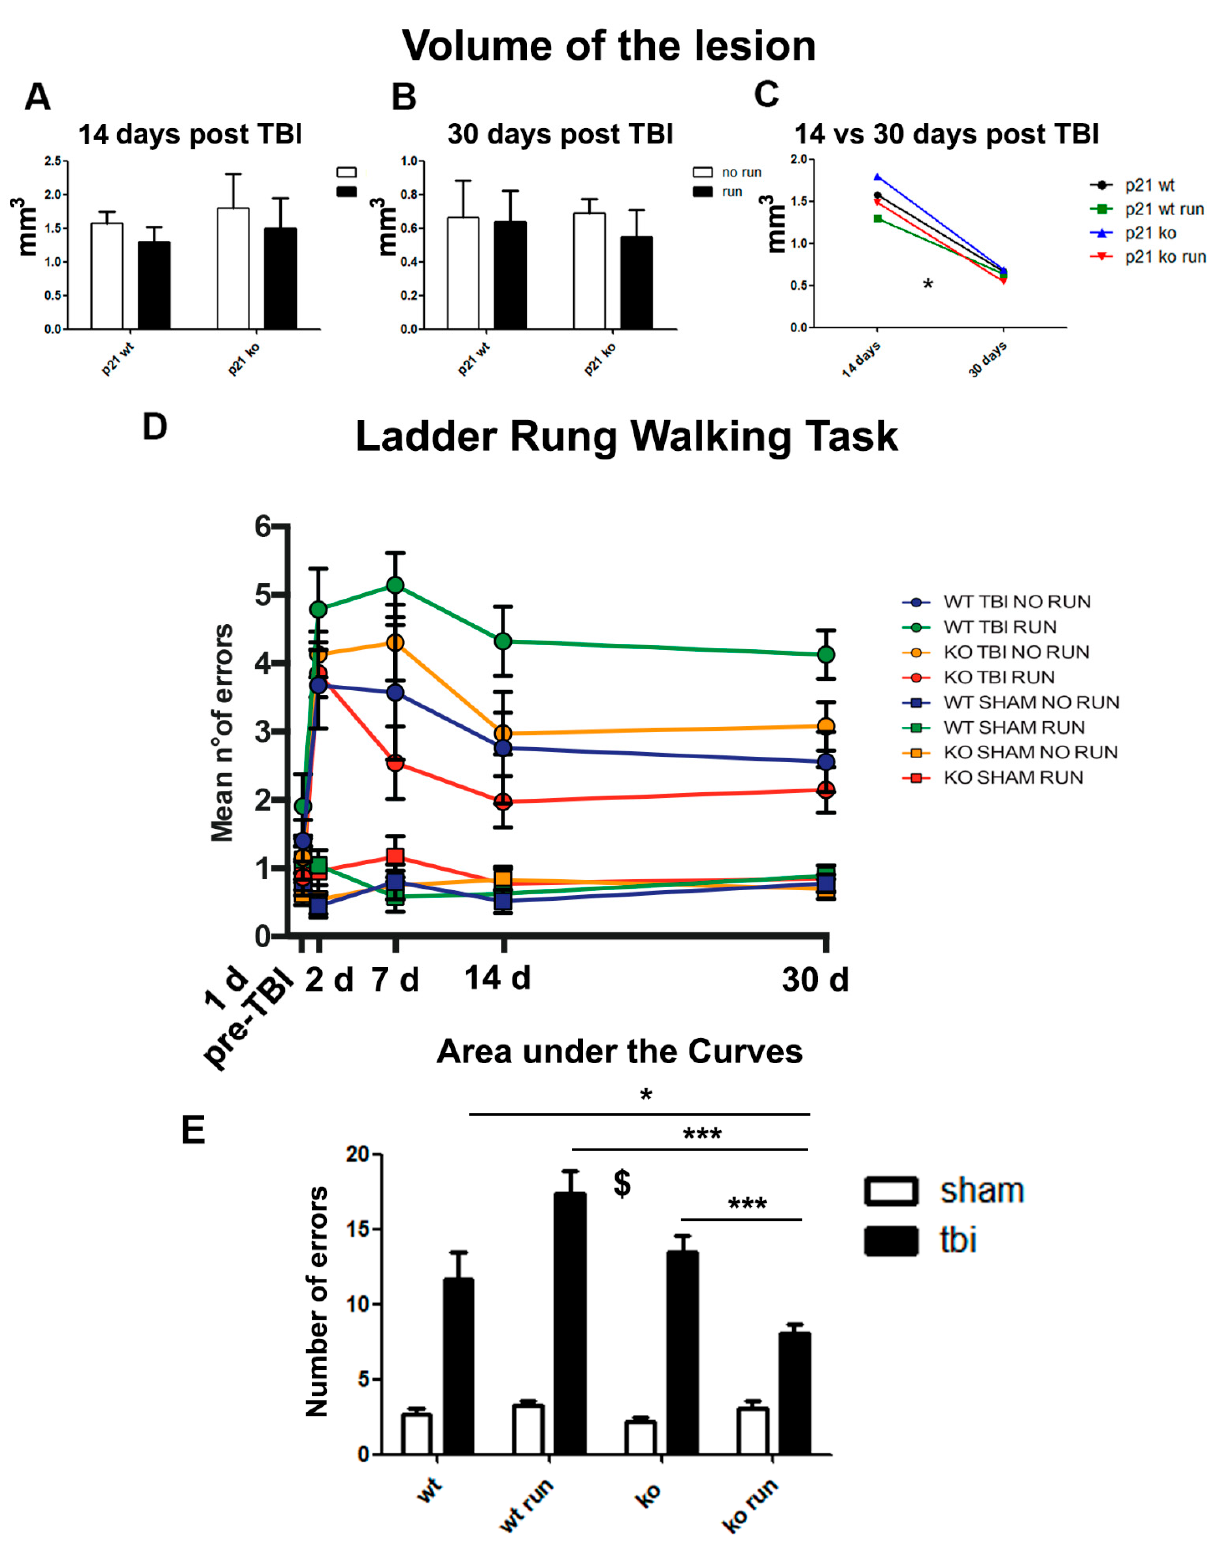
Figure 7. Anatomical and functional recovery following TBI. ( A , B ) Graphs show the average volumes of the lesions 14 ( A ) and 30 ( B ) days after the TBI procedure in the four experimental groups. ( C ) Histograms indicate the decreased average volumes of the lesions from 14 to 30 days post TBI in the four different experimental conditions (time effect: F (4,28) = 22.08; p < 0.05). ( D ) The graph indicates the mean number of errors per group at each time point. The same color shows an